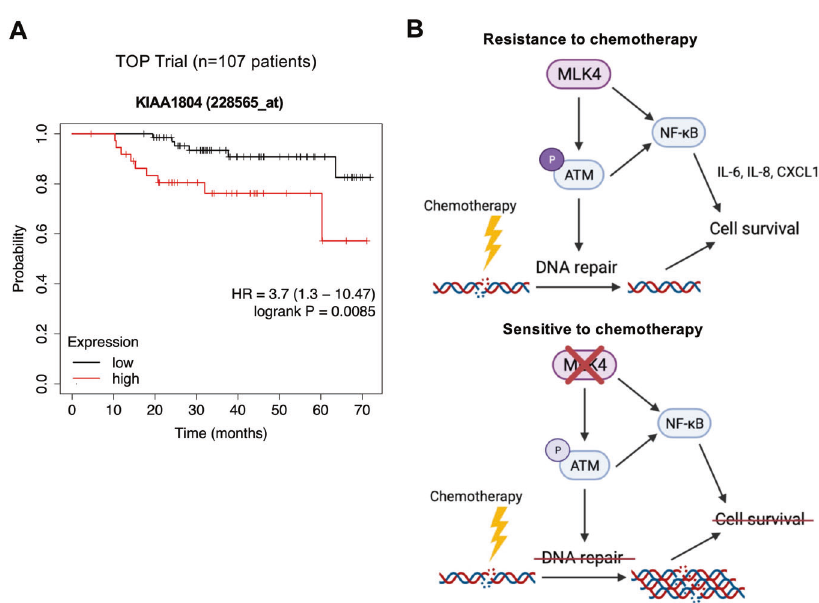
Fig. 7 High MLK4 expression predicts poor prognosis in patients treated with anthracycline-based neoadjuvant chemotherapy. A Probability of overall survival in breast cancer patients from neoadjuvant TOP trial based on MLK4 mRNA expression in tumor tissue, evaluated using pre-treatment biopsies. Patients with estrogen receptor (ER)-negative tumors were treated with anthracycline (epirubicin) monotherapy. The OS was analyzed using the KMplotter tool, with auto-selected best cutoff. Graphic illustrations were obtained from Kmplot. com. B Schematic illustration of the proposed role of MLK4 in TNBC